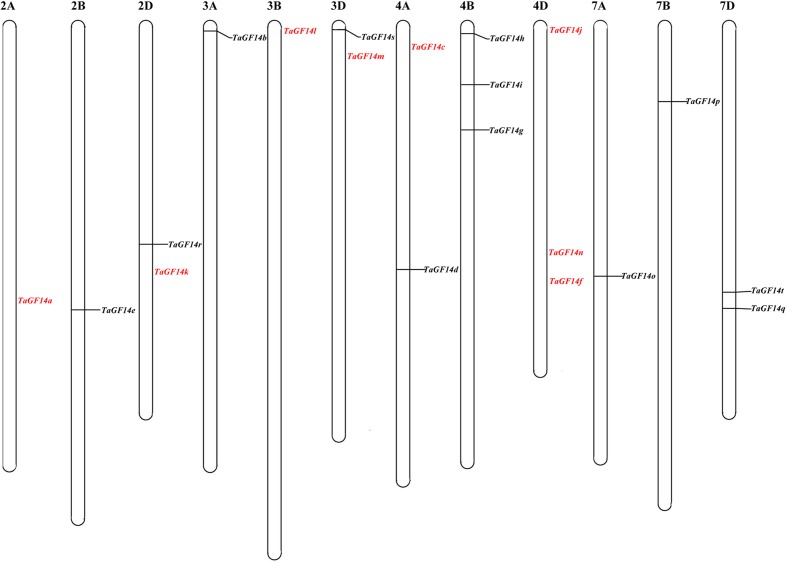
Chromosome localization of TaGF14s based on the reference sequence (TGACv1.0) of wheat genome (International Wheat Genome Sequencing Consortium [IWGSC], 2014). The text in red color presented that the genes were not physically mapped in the reference genome.